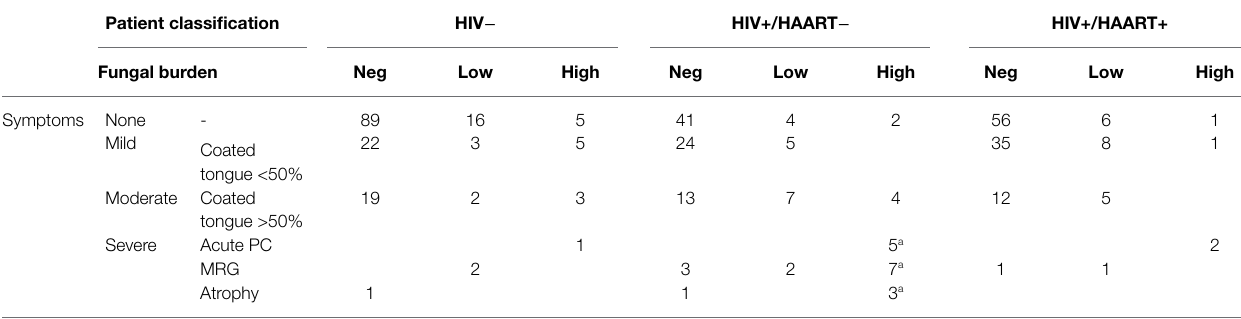
TABLE 1 | Distribution of symptoms according to semi-quantitative yeast culture results. Patient